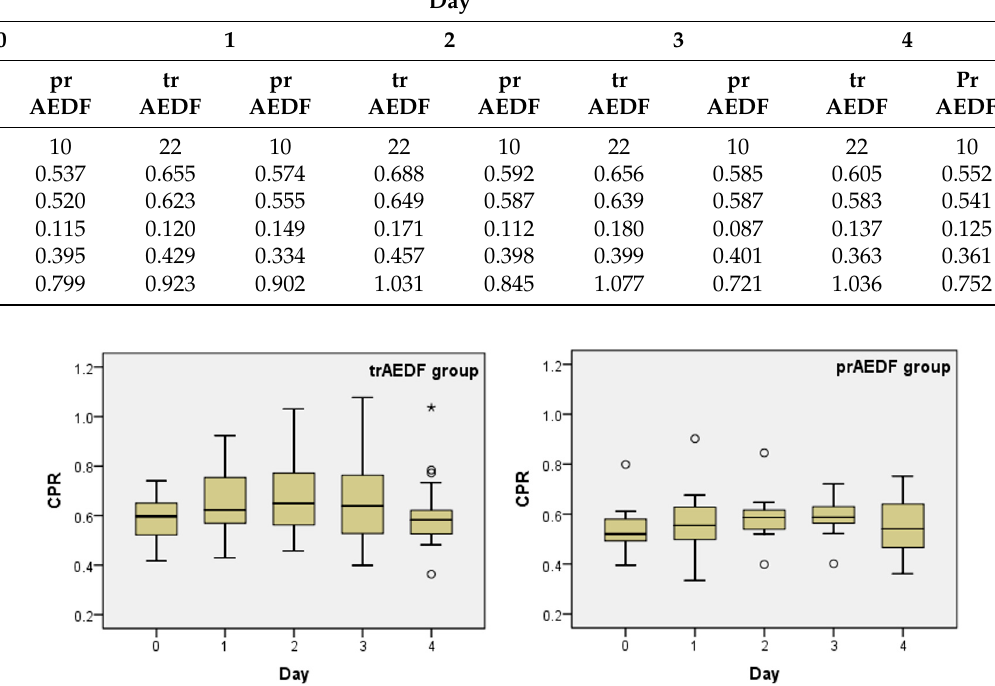
Figure 3. Boxplot charts on the cerebroplacental ratio (CPR) prior (day 0) and in the first 4 days after maternal dexamethasone administration in the two groups (tr/prAEDF = transiently re- stored/persistent absent end-diastolic flow in umbilical artery group).